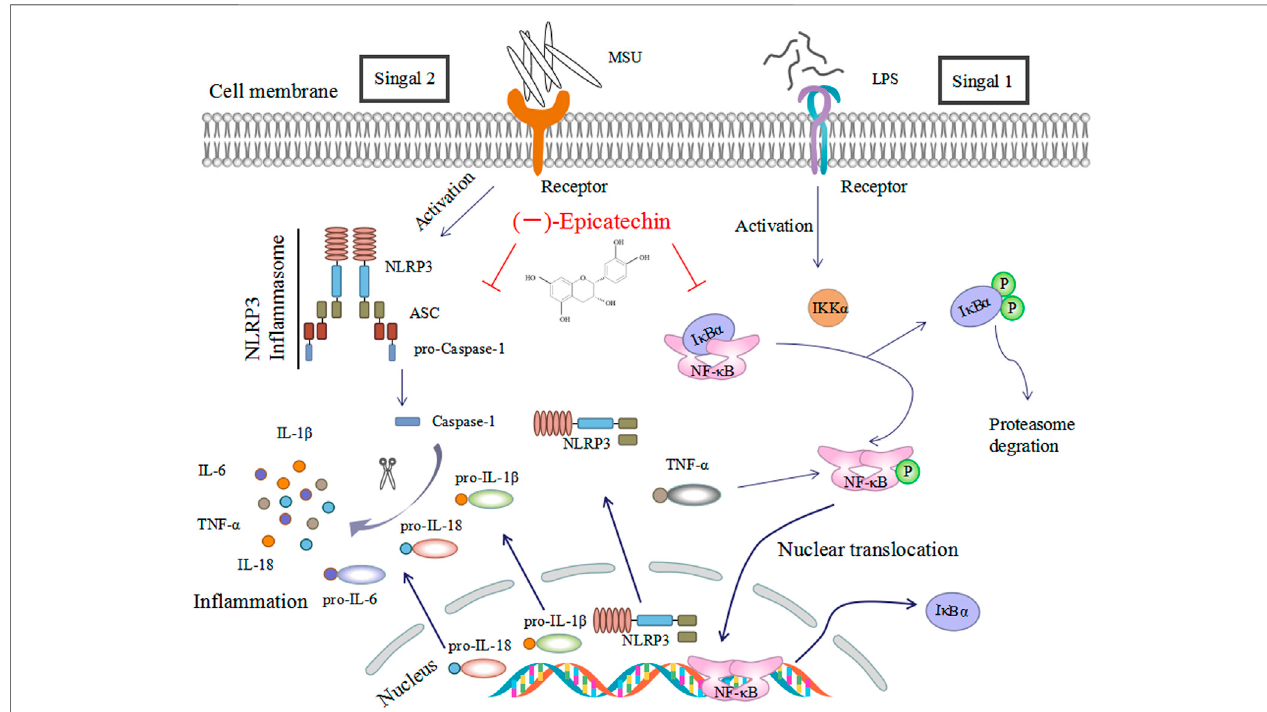
FIGURE 8 | Schematic diagram of the mechanism of EC in the treatment of acute gouty arthritis. EC relieved acute gouty arthrities through inhibiting NF- κ B signal transduction, weakening NLRP3 in fl ammasome activation and reducing IL-1 β and IL-18 secretion. LPS: lipopolysaccharide; MSU: monosodium urate crystals; and EC ( −